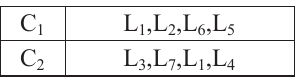
Fig 6. Nominal Label Matrix